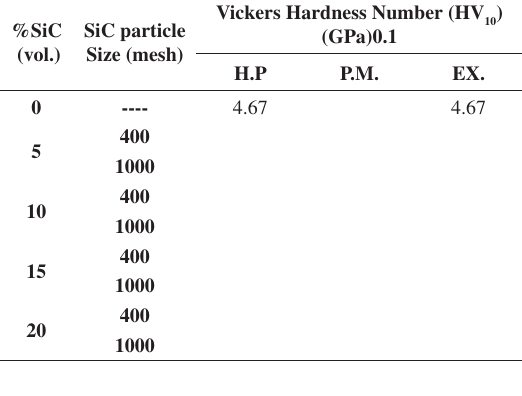
Table 3. Vickers hardness number of Al-SiC composites at different processing condition. %SiC SiC particle (vol.) Size (mesh)